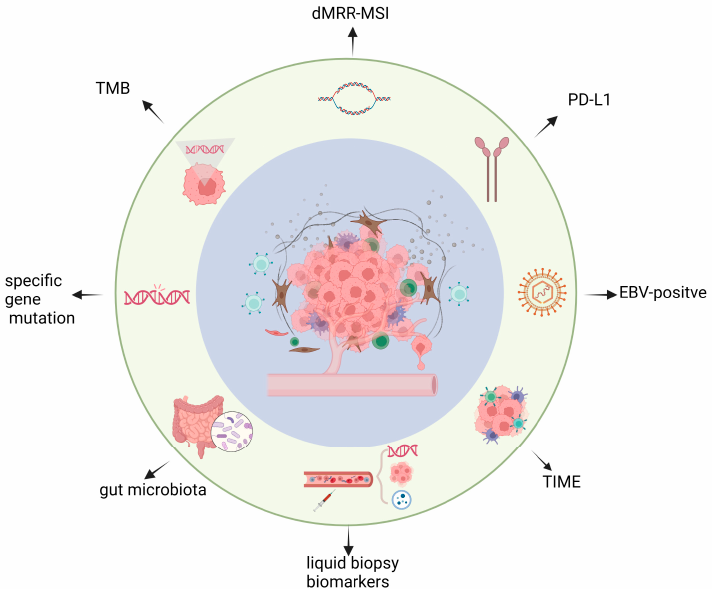
Figure 1. Overview of predictive biomarkers for immune checkpoint inhibitors in gastric cancer. Key elements on predictive biomarker progress for the e ffi cacy of immune checkpoint inhibitors therapy are brie fl y precented in the fi gure, including PD-L1, dMRR/MSI, TMB, EBV-positive status,